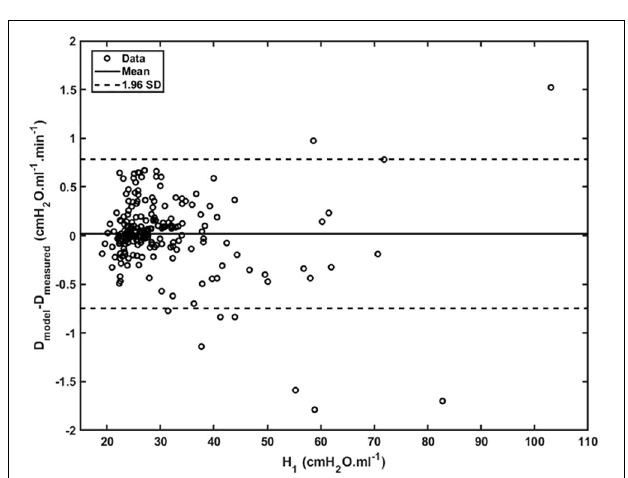
FIGURE 5 | Difference between modeled and measured D rate as a function of H 1 (open dots). Mean is represented by the full line whereas 95% interval ( ± 1.96 SD) is represented by dashed